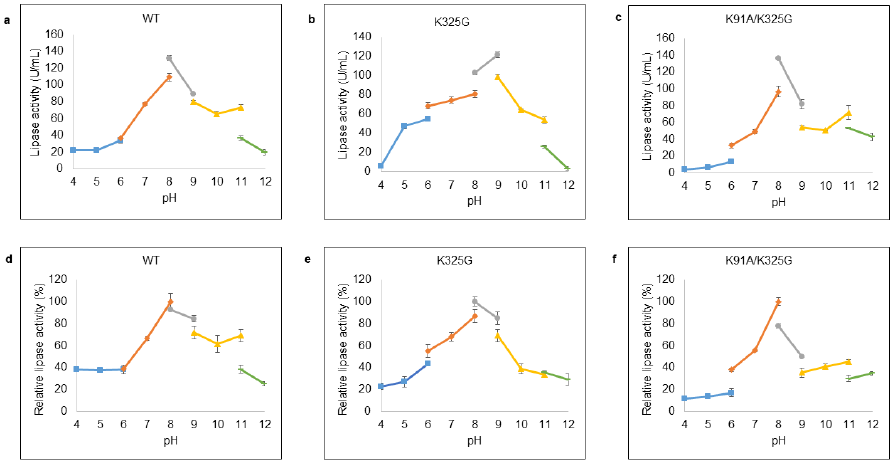
Figure 7. Effect of pH on lipase activity of purified ( a ) WT, ( b ) K325G, and ( c ) K91A / K325G. Optimum pH was identified by varying the pHs (4–12). Tested lipase was assayed at 25 ◦ C for 10 min. The protein concentration of each tested lipase was standardised to 0.5 mg / mL. While, effect of pH on lipase stability of purified ( d ) WT, ( e ) K325G, and ( f ) K91A / K325G. The buffer systems used are as follows: sodium acetate (pH 4–6); sodium phosphate (pH 6–8); Tris-HCl (pH 8–9); glycine-OH (pH 9–11) and sodium hydrogen phosphate (pH 11–12). The purified lipase was pre-incubated at the tested pHs for 30 min. Relative activity was calculated based on the control of the experiment. Non-incubated sample as control (100%) were employed to calculate the relative activity. Error bars represent standard deviations of means ( n = 3 ).